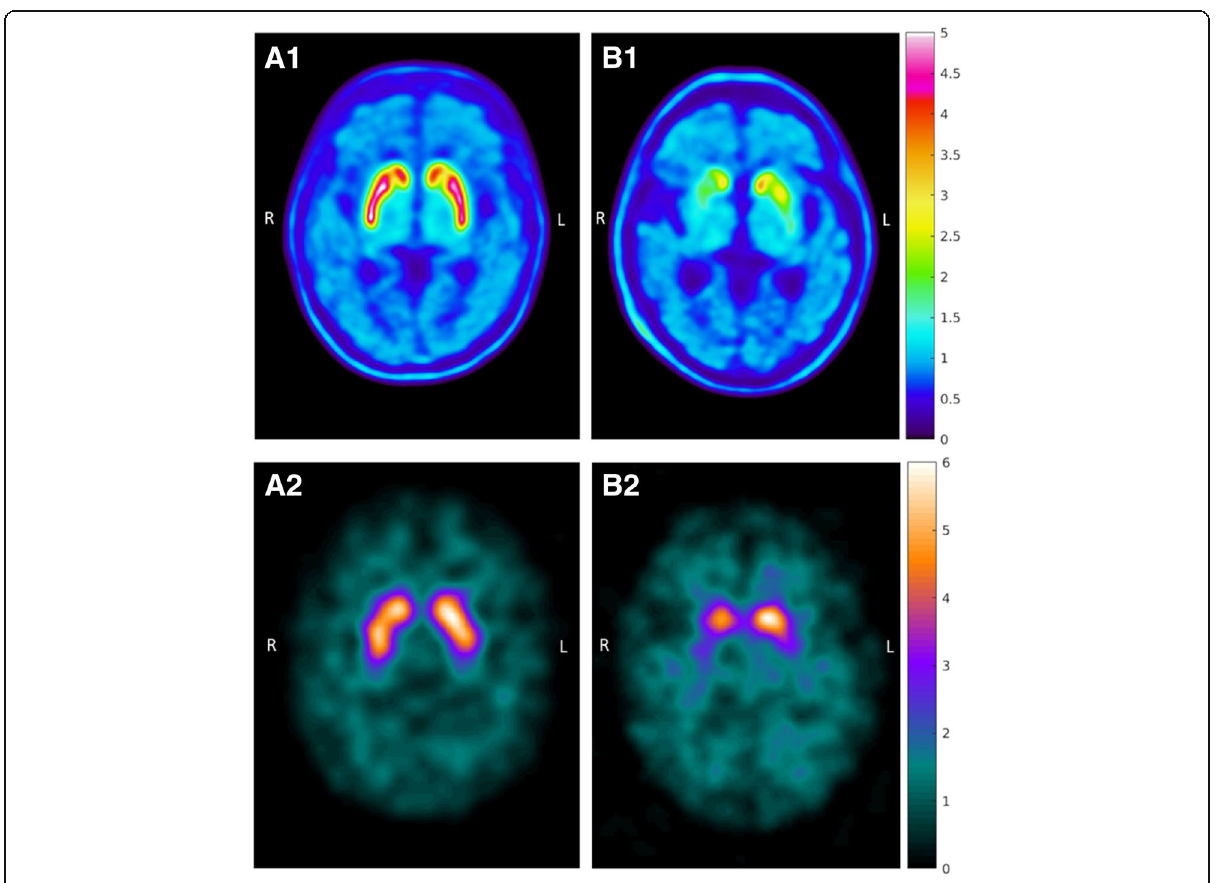
Fig. 1 Examples of [ 18 F]FE-PE2I PET and [ 123 I]FP-CIT SPECT images in the same individuals. Representative images of FE-PE2I PET (parametric DVR images) and FP-CIT SPECT (SUR images) of the same two subjects. Healthy control examined A1 with FE-PE2I and A2 with FP-CIT. Patient with parkinsonian syndrome since 6 months examined B1 with FE-PE2I PET and B2 with FP-CIT SPECT. PET image scale : DVR (= BP ND + 1). SPECT image scale : activity uptake in striatum divided by cerebellum